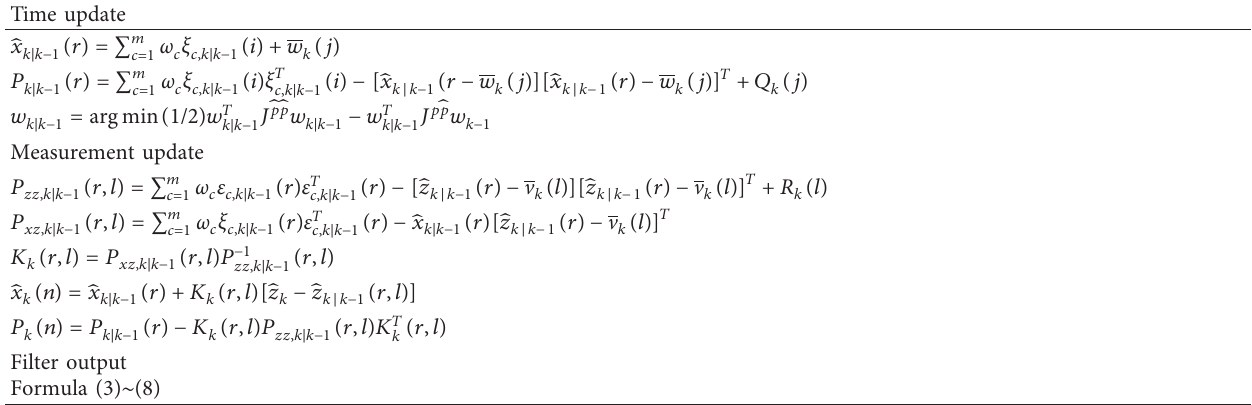
Table 1: Computation steps of the